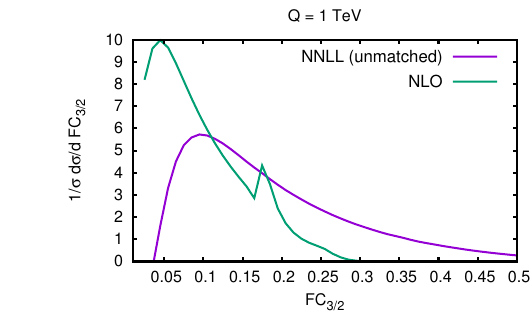
The characteristic transverse momentum of the soft radiation is k collinear radiation occurs at scales k lower than the collinear scales for x < 1, the two coincide for x = 1, and the situation is inverted for 2 > x > 1. For a given value v of the observable, the typical size of the